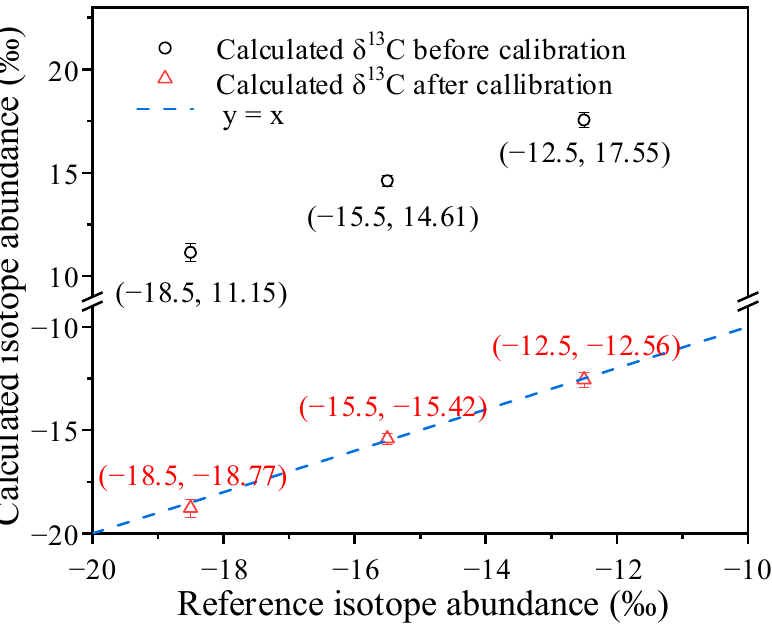
Figure 6. The relationship between the calculated δ 13 C values and the reference values.